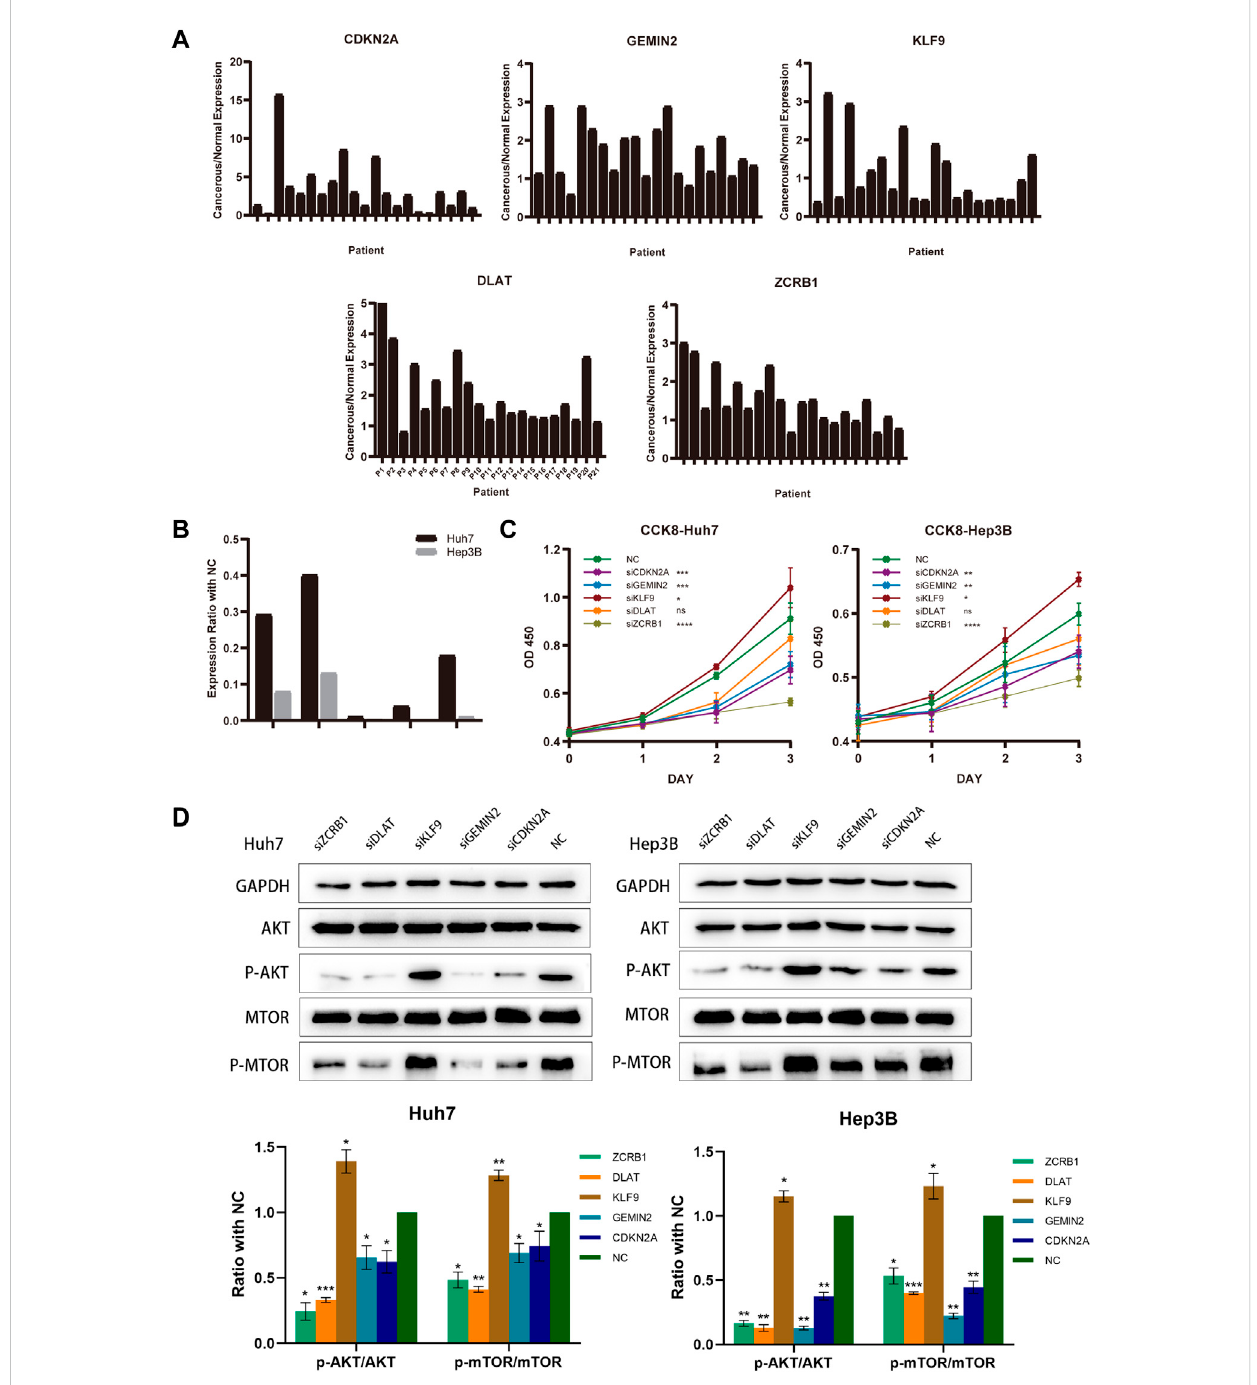
FIGURE 9 Model-constructedgenesexpressioninHCCtissuesandeffectsonHCCcellbiologicalsignature. (A) qRT-PCRanalysisofmodel-constructedgene expressioninpairedtumorsandadjacentnormaltissuesfrom21HCCpatients. (B) Theef fi ciencyoftransfectionwasdeterminedbyqRT-PCR. (C) CCK-8 was used to determine growth curves for transfected Huh7 and Hep3B cellsB cells. (D) AKT, p-AKT, mTOR, and p-mTOR expression in different groups were detected with western